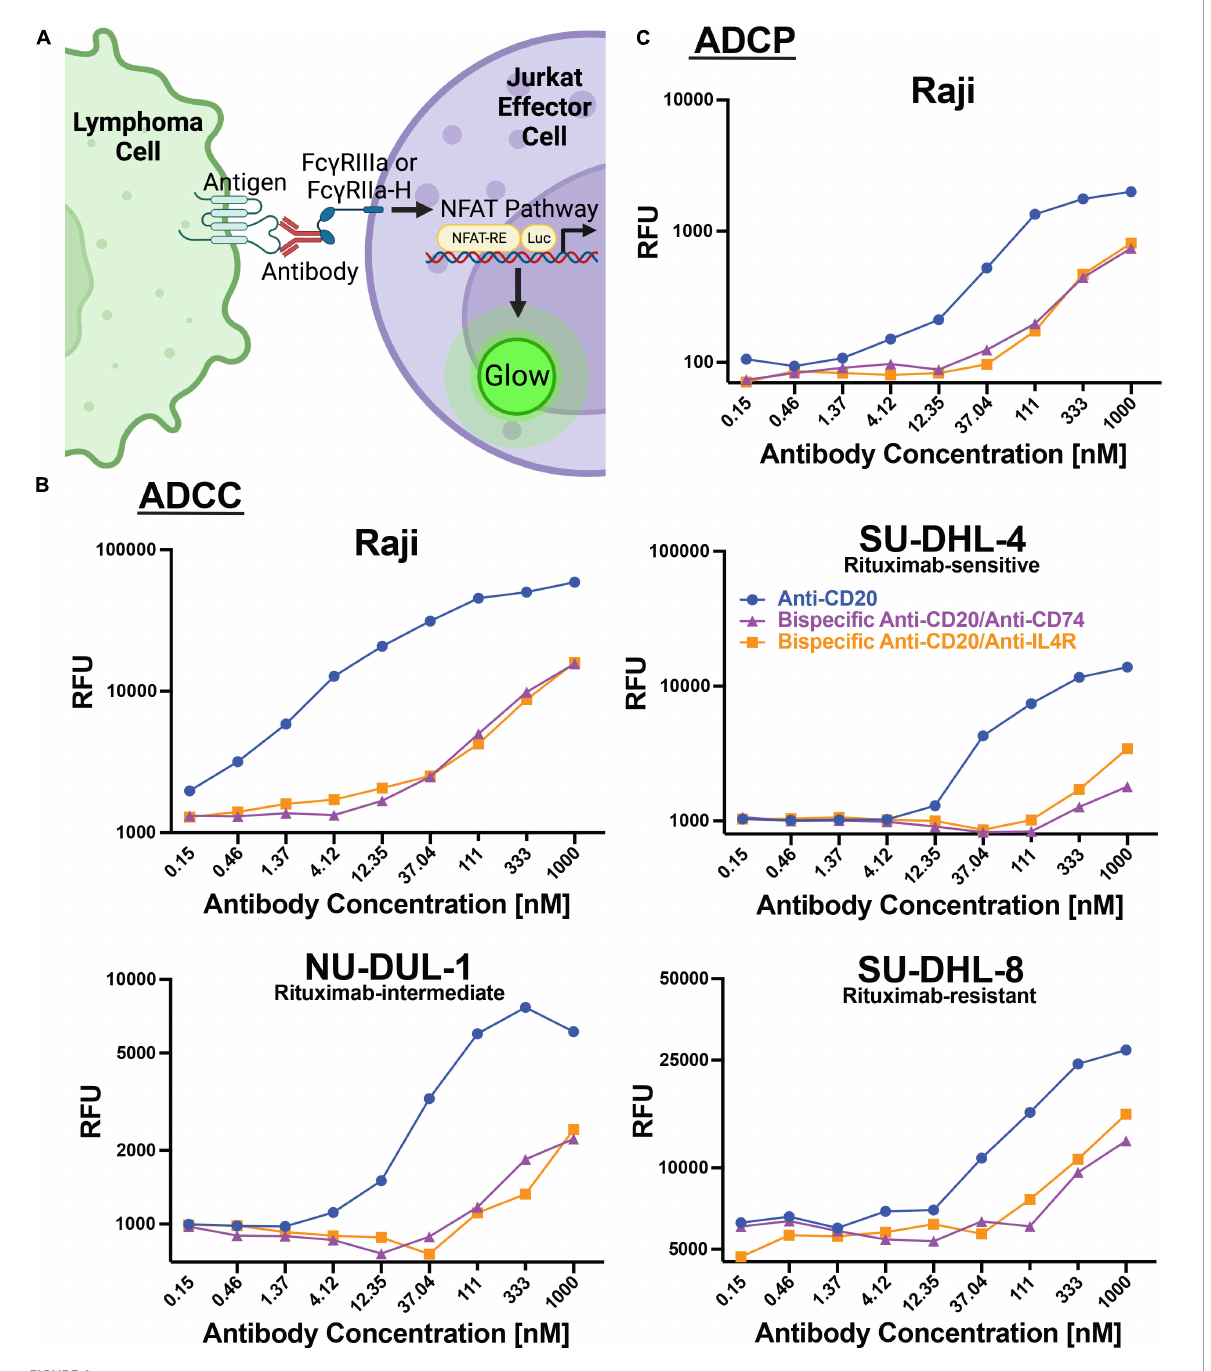
FIGURE4 Antibodies induce ADCC and ADCP responses within lymphoma cell lines. (A) Schematic representation of the assays used to measure ADCC and ADCP response within modified Jurkat effector cells. Created with BioRender.com. (B) Line graphs of the relative fluorescent units (RFU) of luciferase produced by ADCC activation of Fc γ RIIIa modified Jurkat cells when incubated with Raji, SU-DHL-4, NU-DUL-1, or SU-DHL-8 DLBCL cell lines and serial diluted anti-CD20 (Blue), bispecific anti-CD20/anti-CD74 (Purple), or bispecific anti-CD20/anti-IL4R (Orange) antibodies. (C) Line graph of the relative fluorescent units (RFU) of luciferase produced by ADCC activation of Fc γ RIIa-H modified Jurkat cells when incubated with Burkitt’s lymphoma Raji cells and serial diluted anti-CD20 (Blue), bispecific anti-CD20/anti-CD74 (Purple), or bispecific anti-CD20/anti-IL4R (Orange)